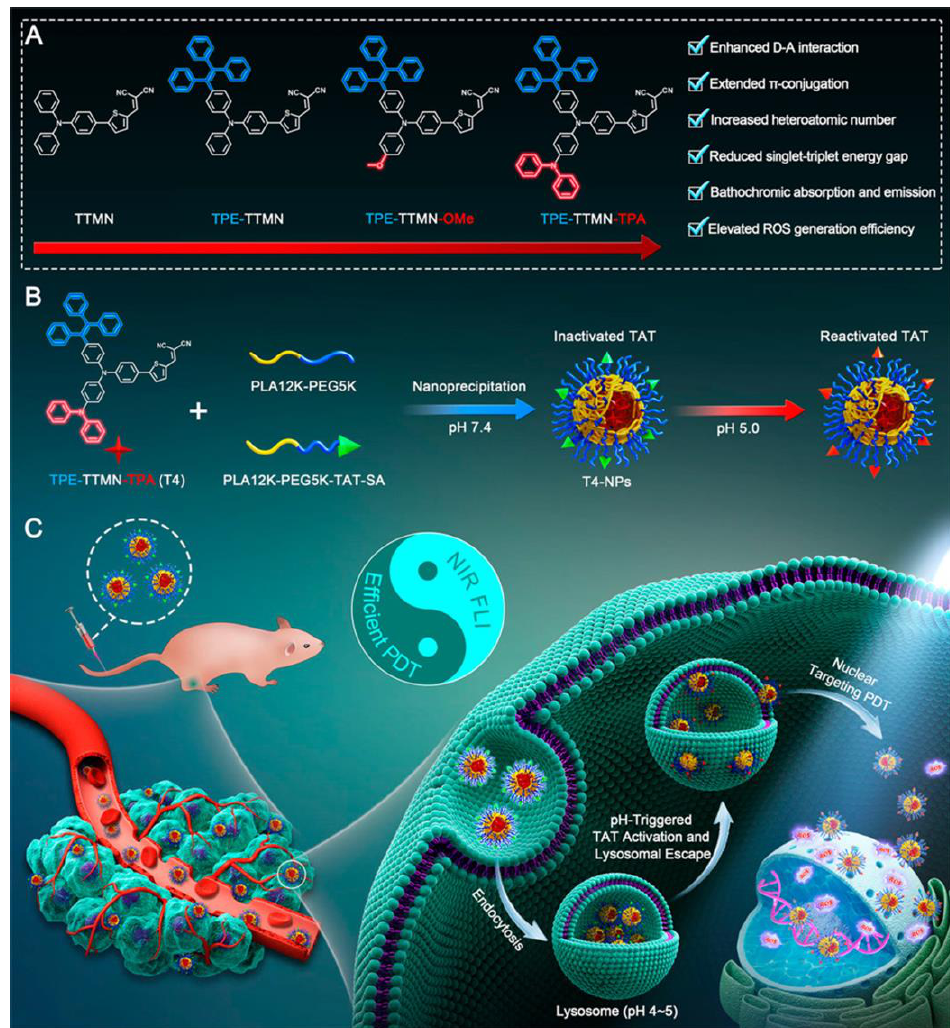
Figure 20. Schematic illustration of ( A ) molecular engineering of TPE-TTMN-TPA, ( B ) construction of nucleus-targeted T4-NPs, and ( C ) applications in PDT. Reprinted with permission from Ref. [60]. Copyright 2021 American Chemical Society.